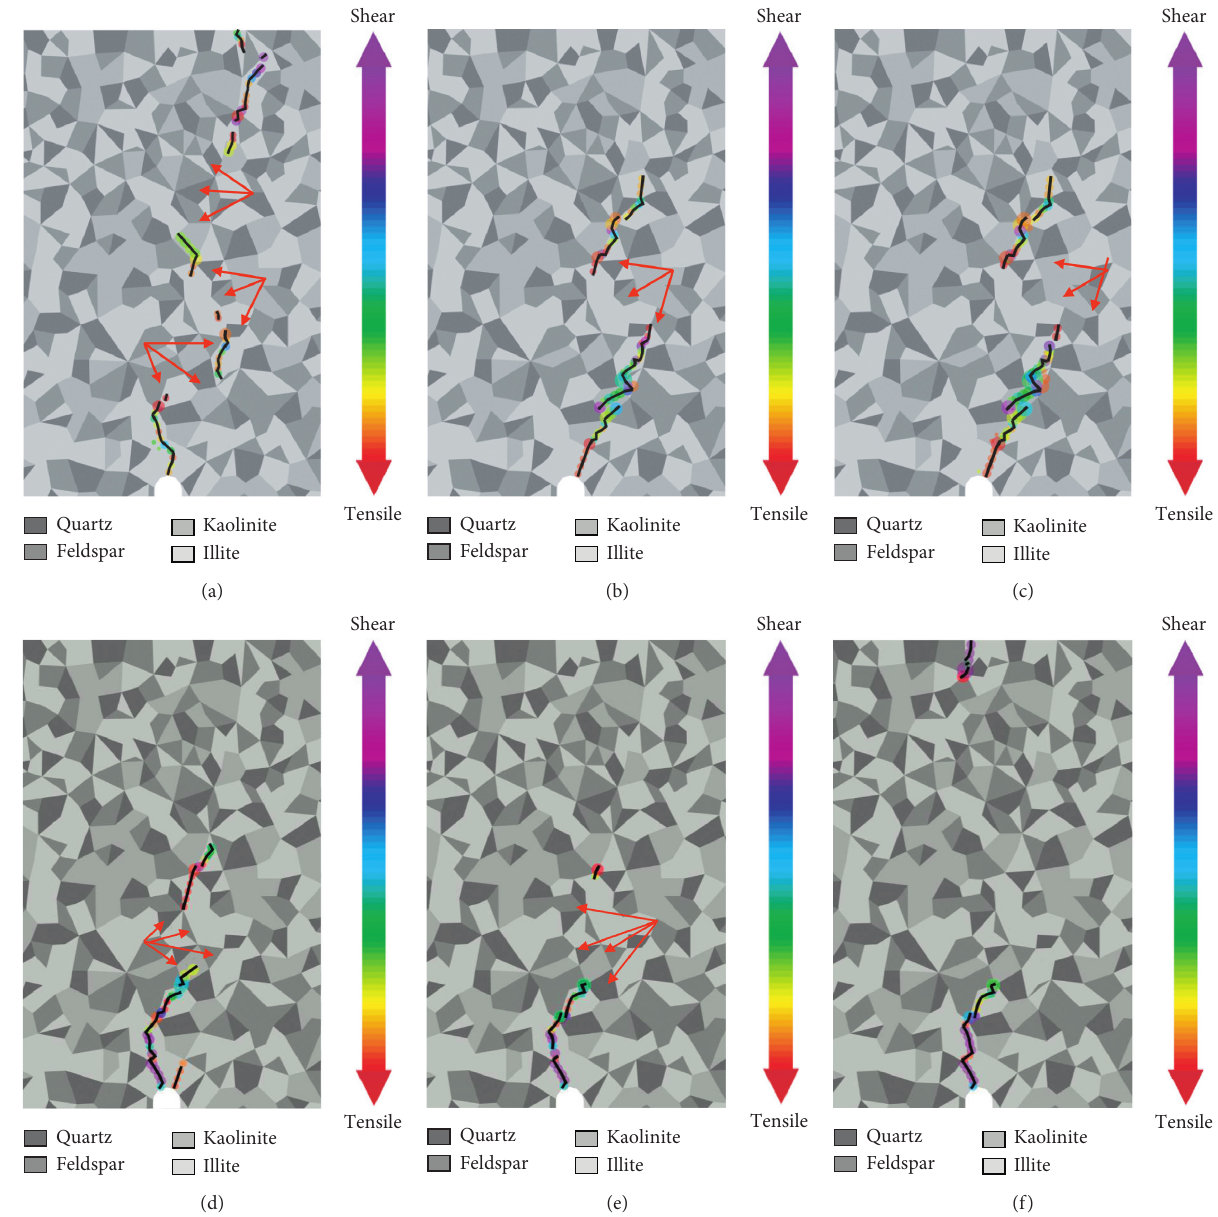
Figure 11: The AE location when the second large-scale en echelon intermittent fractures were formed under six different loading methods. The red arrows refer to the strong mineral aggregate. Red dots are the AE location of tensile fractures, purple dots are the AE location of shear fractures, and the colors between the two are the AE location of tensile-shear fractures. The size of the dot represents the level of AE